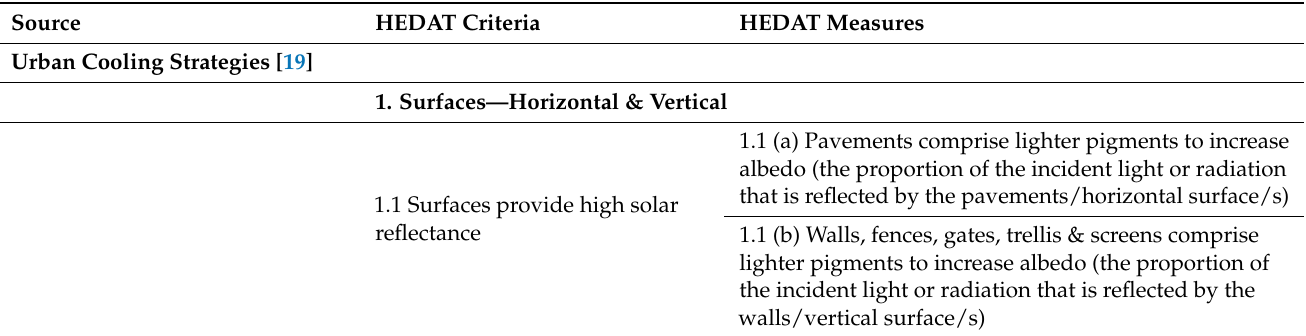
Table 1. Environmental Design criteria sources and their relationship to the HEDAT criteria and